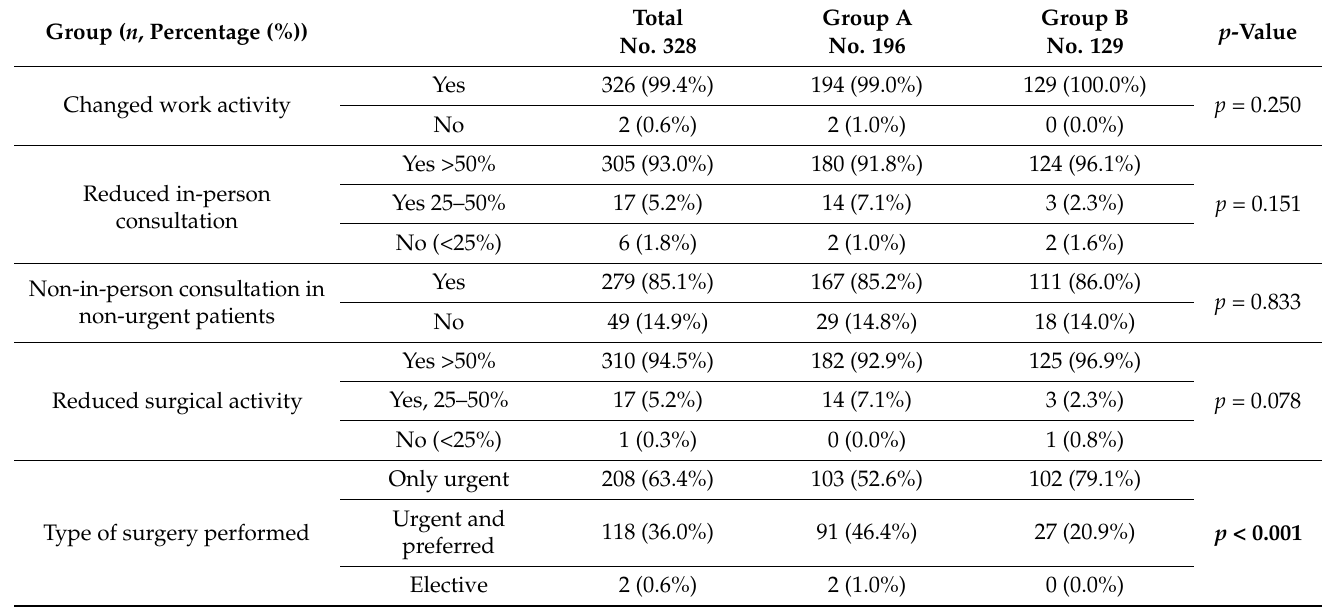
Table 2. COVID-19 impact on care